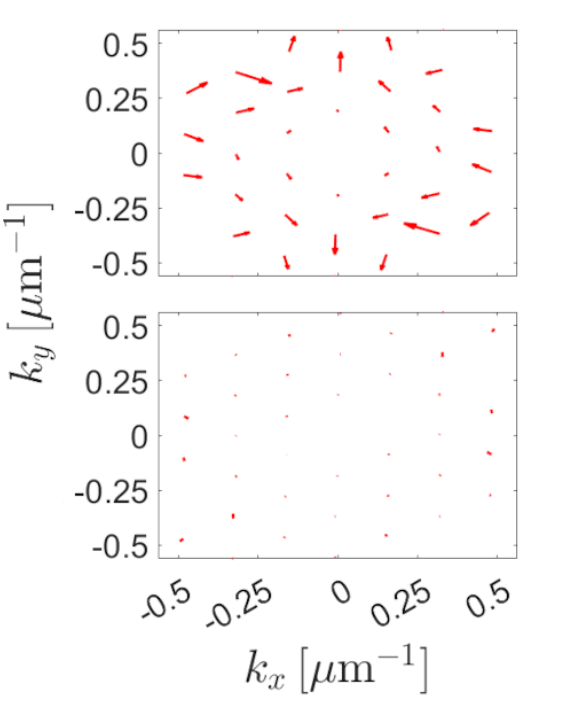
Figure 2. Arrows showing displacement of peaks in Fourier space before and after irradiation with linear polarization (top) and before and after a complete cycle of linear + circular polar- ization (bottom). Arrow magnification: x10.